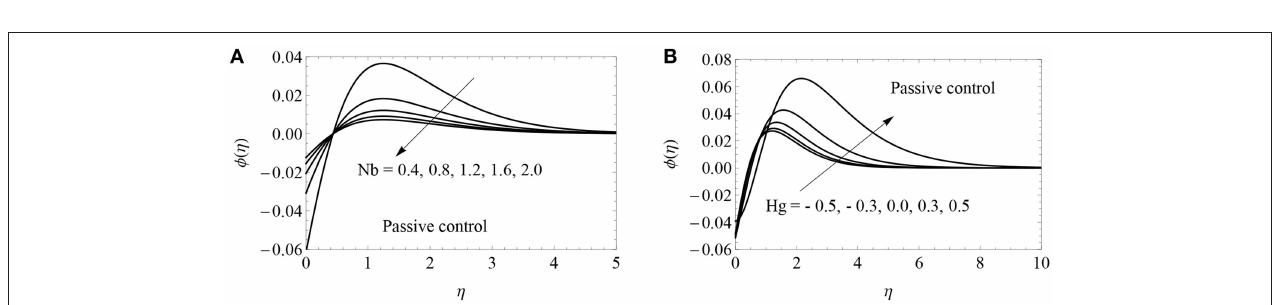
0.1, c 0.5, Nt 0.2 and Bi = = = =